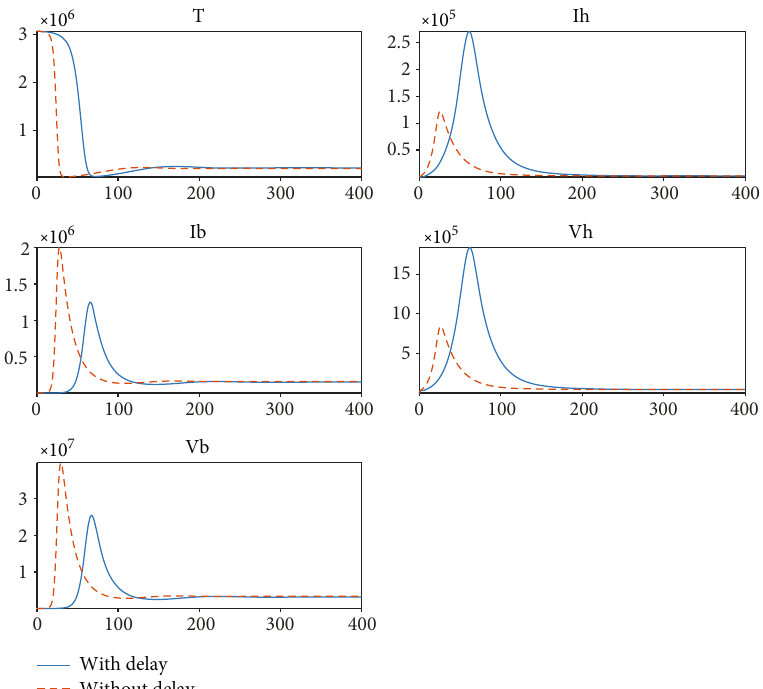
Figure 3: Comparing the dynamics of system (1) with and without delay. Parameter values are as shown in Table 1. Horizontal axes represent time in days.